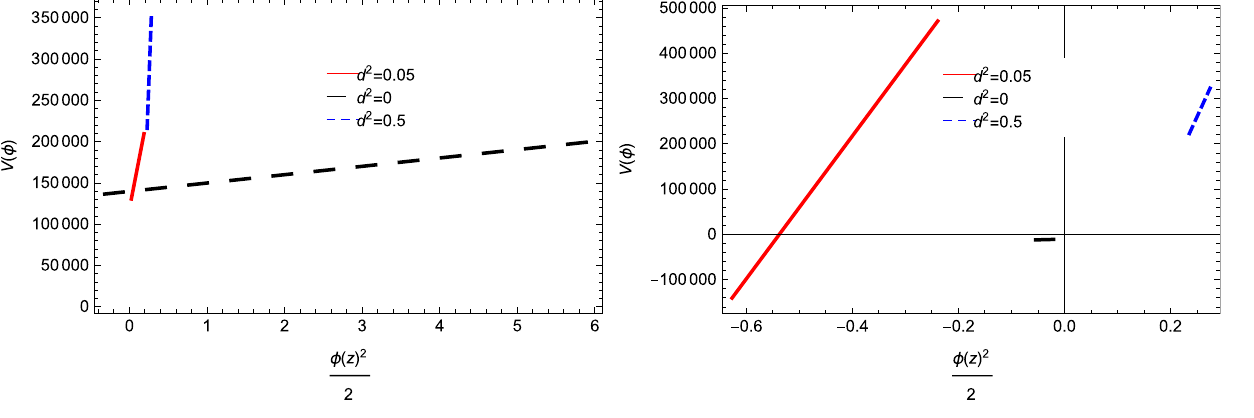
Fig. 13 Plot of φ verses V for u = 1 and u = 2 . 002 for K-essence scalar field model